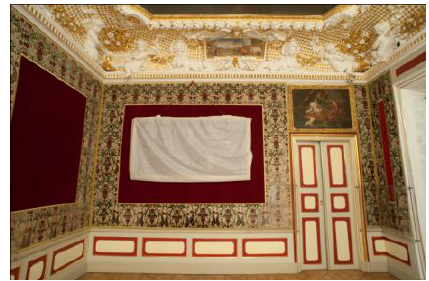
Figure 2. A fragment of the historical sleeping room of the Queen at the Wilanów Palace (Warsaw, Poland) Point clouds acquired from terrestrial laser scanning (Z+F 5003 scanner) and digital images (Nikon D3X, Hasselblad H4D cameras) were utilised. Images of facades were taken in